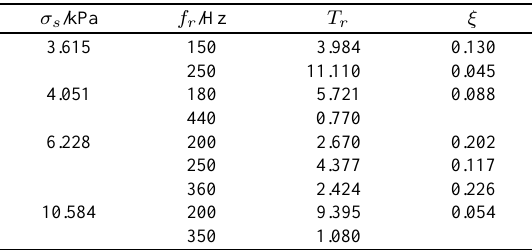
Table 4 Vibration transmissibility of honeycomb paperboard ( T = 40